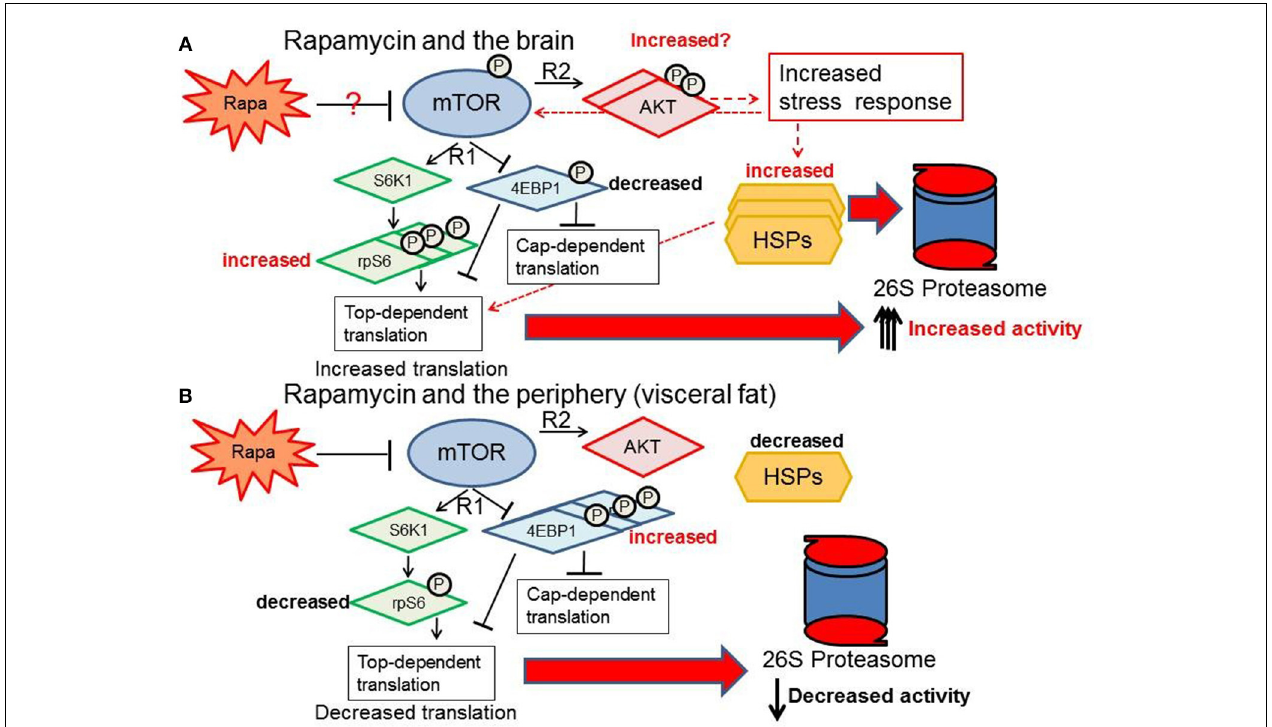
FIGURE 12 | Response of the proteasome-chaperone network differs between the brain and periphery. (A) Rapamycin treatment may stimulate AKT in the brain, increasing proteasome-related chaperones through rp-S6 top-dependent translation and a non-cannonical stress response pathway